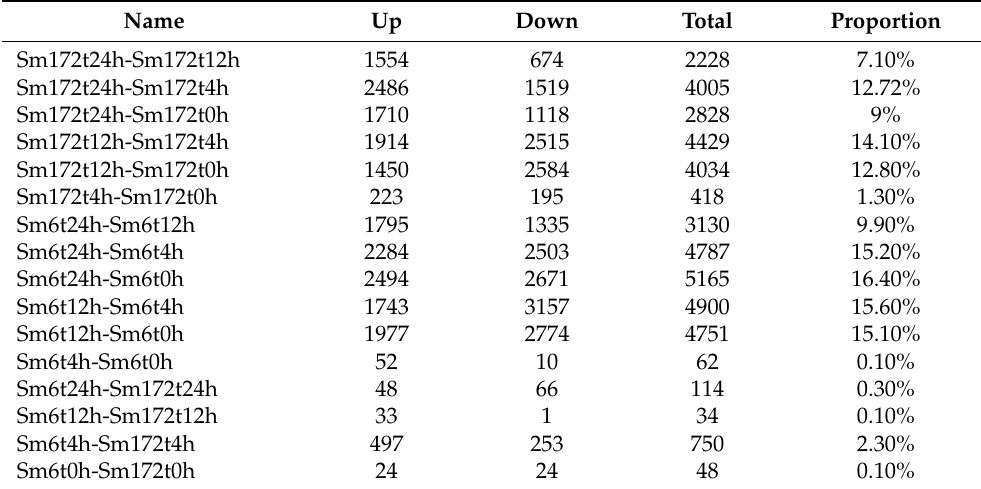
Table 7. Summary of differentially expressed genes.